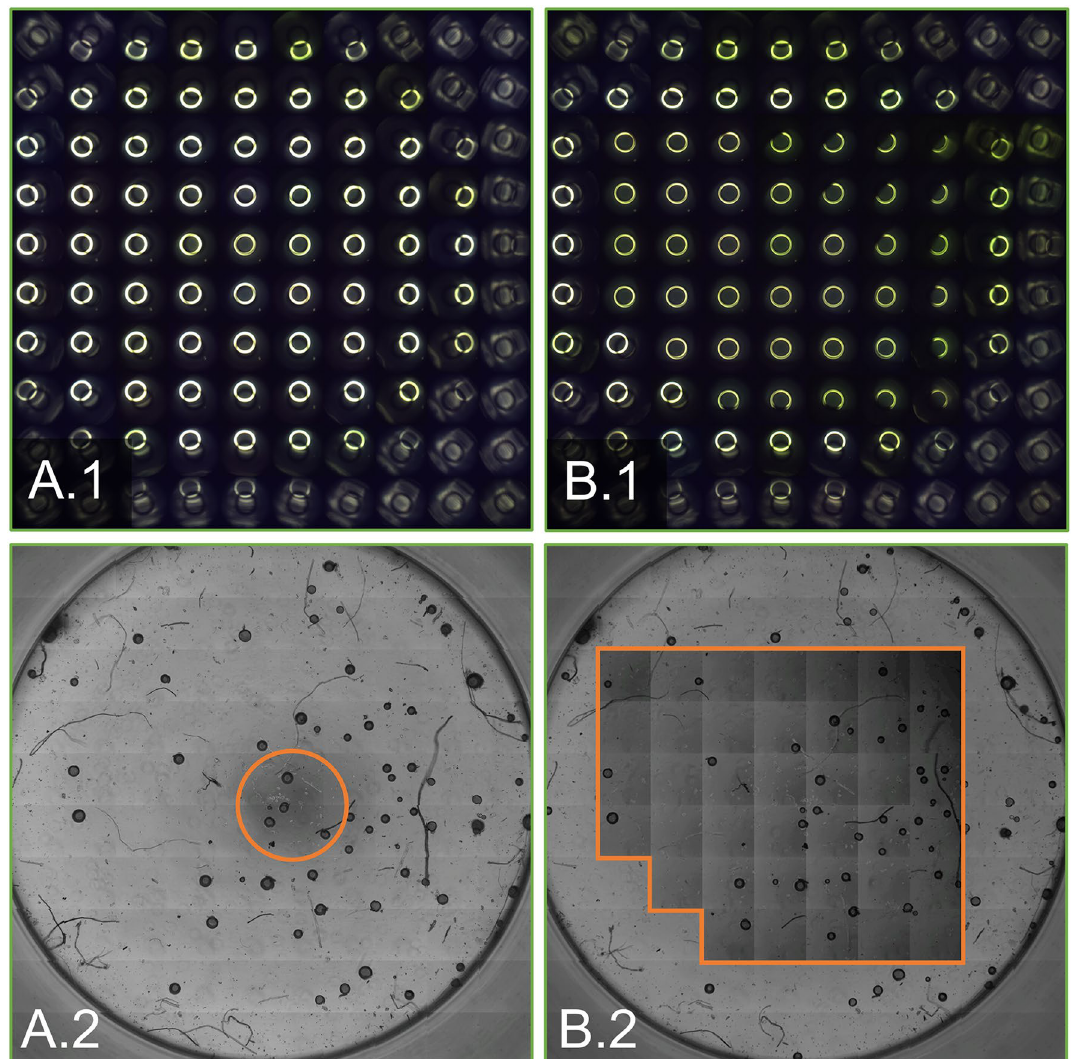
Figure 7. Comparison of the phase contrast images in one well of a 96-well MTP, 10x magnification. ( A ) Standard phase contrast. ( B ) Adaptive phase contrast. ( A.1/B.1 ) Condenser annulus and phase ring alignment ( A.2/B.2 ) Phase contrast images. Phase contrast areas are outlined in orange.